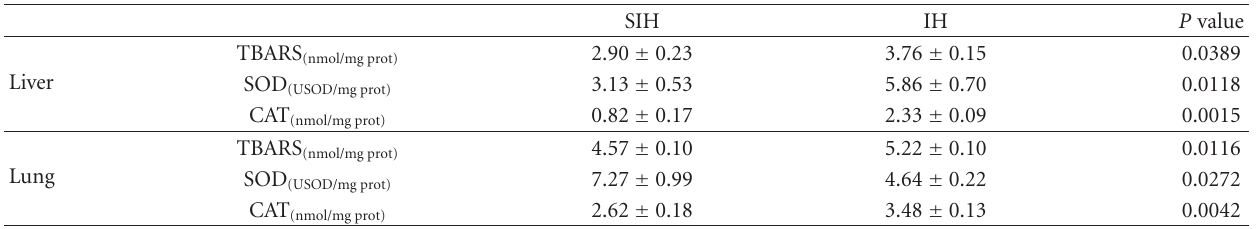
Table 1: The e ff ect of intermittent hypoxia on hepatic lipid peroxidation as shown by the TBARS assay and liver antioxidant enzyme activity.